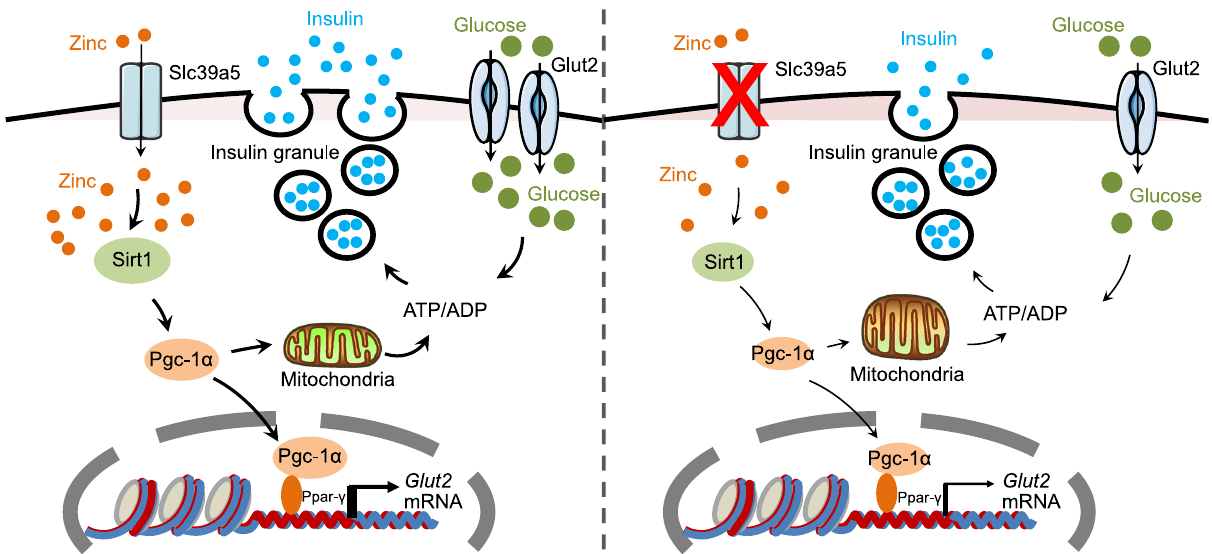
Figure 6. Schematic model depicting the proposed role of Slc39a5 in pancreatic β -cells. An appropriate level of intracellular zinc is required for glucose-stimulated ATP synthesis and insulin secretion (left). Slc39a5 de fi ciency (right) results in impaired glucose-stimulated zinc uptake, Sirt1-Pgc-1 α signaling, Glut2 expression, ATP synthesis and glucose-stimulated insulin